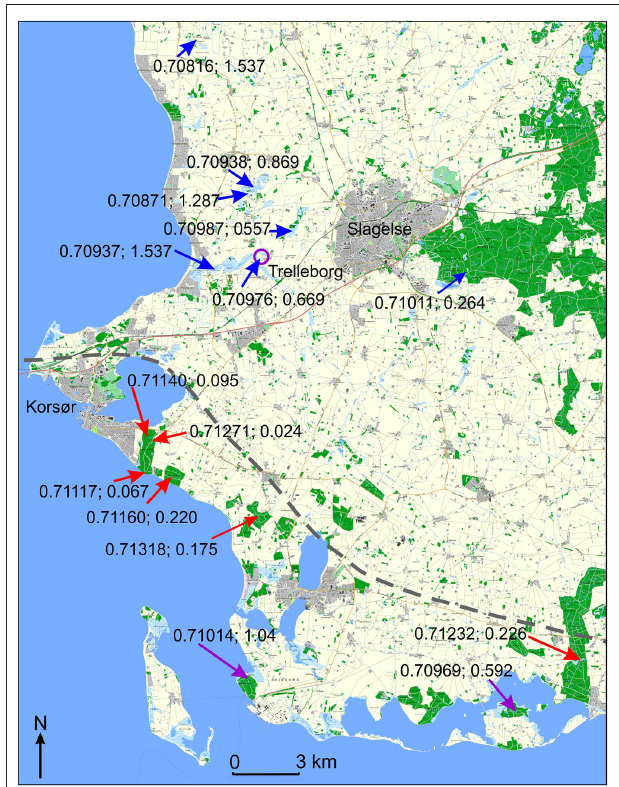
FIGURE 5 | Map of study area S2, southwestern Zealand, showing location of sample stations. 87 Sr/ 86 Sr ratio and strontium concentration are shown for each sample. Sample number and detailed information on sample location and laboratory data are given in Table 1 . The dashed line indicates the position of a lateral moraine associated with a glacial advance from the southeast dated to about 17,000 years ( Houmark-Nielsen et al., 2005). Samples taken within the tills of the glacial advance are marked with red arrows. Samples taken in low-lying lagoonal deposits are marked with purple arrows. Samples taken outside of the advance are marked with blue arrows. For location of study area and full extent of the glacial advance see Figure 1A . Map is based on free data from “Styrelsen for Dataforsyning og Effektivisering, GeoDanmark natur og friluftskort,